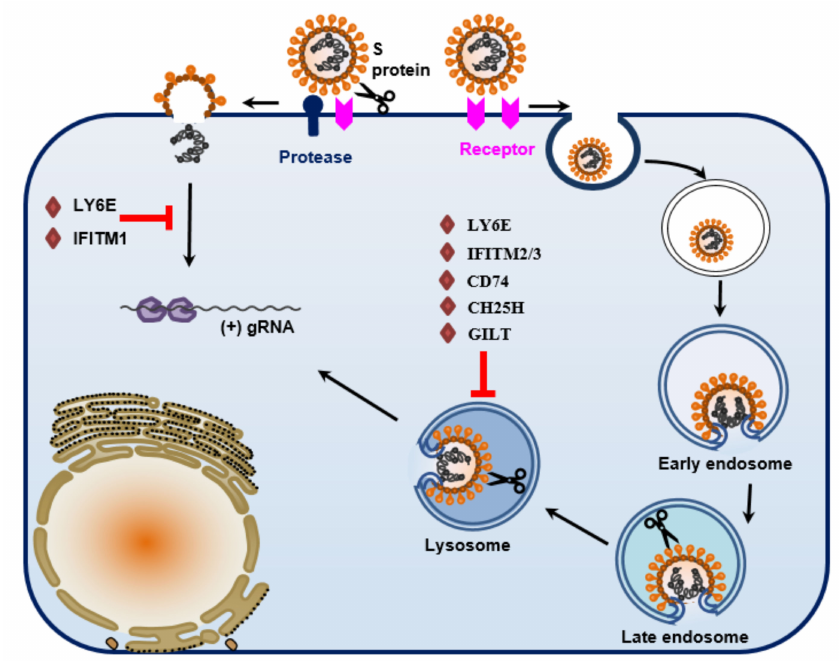
Figure 1. Schematic model for cell entry process of coronaviruses. The virus entry process is initiated by cell binding, which is mediated by the interaction between the viral spike (S) protein and cellular receptor and/or attachment factor, followed by membrane fusion and release of the viral genome into the cytoplasm for replication. Membrane fusion occurs at the plasma membrane (early entry) in a pH-independent manner or in endosome/lysosome compartments (late entry), in a pH-dependent manner, or both. Proteolytic cleavage of the S protein is a critical priming step for membrane fusion. Cleavage can occur at the plasma membrane by TMPRSS2 or trypsin or in the endosome/lysosome by cathepsin. Membrane fusion occurring at the cell surface could be inhibited by interferon-inducible host proteins LY6E and IFITM1. Membrane fusion in the endosome/lysosome can be restricted by several other interferon-inducible proteins, including LY6E, IFITM2, IFITM3, CD74, CH25H, and